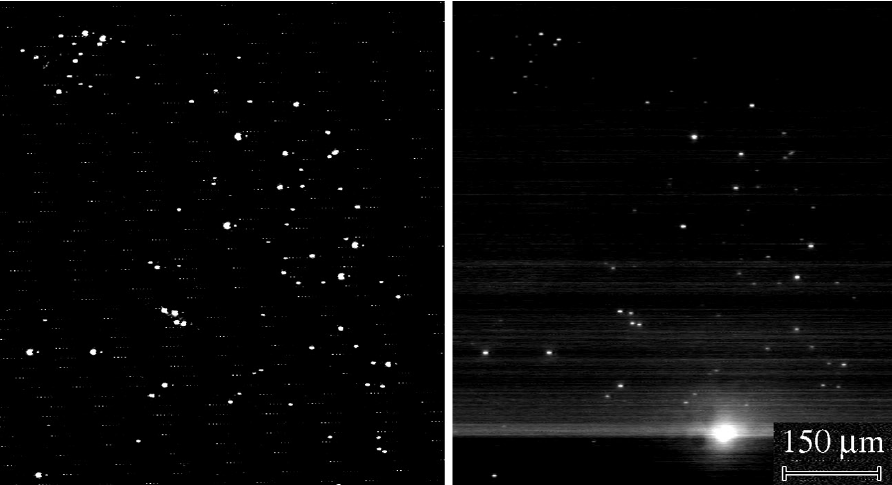
Figure 4. The EBIC images of the selected region at 10 keV after applying negative bias of 15 V ( left ) and then positive bias of 20 V ( right ).